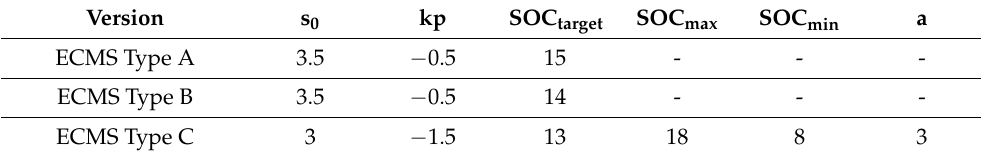
Table 3. Parameters selected for the three ECMS versions.